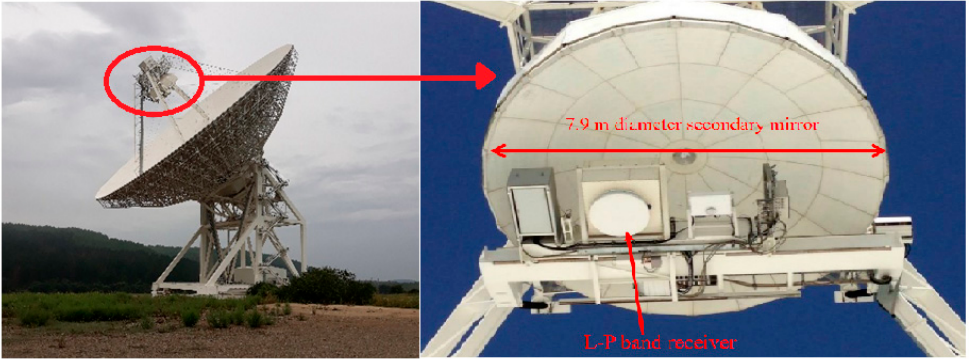
Electronics 2021 , 10 , x FOR PEER REVIEW Figure 2. The Sardinia Radio Telescope (SRT) with its L-P receiver installed on its primary focus.